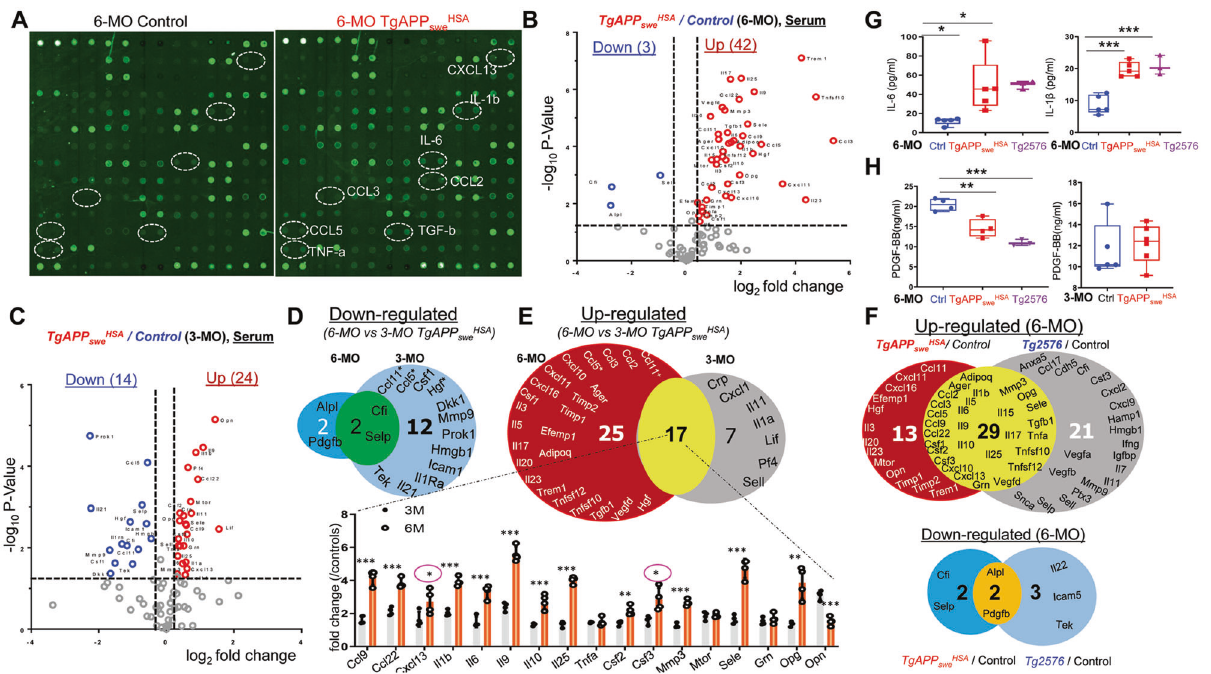
Fig. 5 Increased systemic in fl ammation in TgAPP sweHSA serum samples. A Representative images of serum L-Series label-multiplex antibody arrays of 6-MO control and TgAPP sweHSA mice. B Volcano plots analysis of ( A ). C Volcano plots analysis of the serum L-Series label-multiplex antibody arrays of 3-MO control and TgAPP sweHSA mice. D , E A comparison of the changes of downregulated ( D ) and upregulated ( E ) secreted factors in the antibody array between 3-MO and 6-MO. * p < 0.05, ** p < 0.01, *** p < 0.001, student ’ s t test and correction of multiple comparisons using Holm-Sidak method was applied, circle with asterisk means no signi fi cant change was detected after correction. F A comparison of the changes of the up- and down-regulated secreted proteins in 6-MO Tg2576 over control mice with those detected in 6-MO TgAPP sweHSA mice. G Elisa assays of serum IL1 β and IL6 level in 6-MO control, TgAPP sweHSA and Tg2576 mice. The data are presented as mean ± SD ( n = 5 mice). * p < 0.05, One-way ANOVA. H Elisa assays of serum PDGF-BB level in indicated mice. The data are presented as box and whiskers ( n = 3 – 6 mice). * p < 0.05, One-way ANOVA and student ’ s t test were (Fig. 6C, D) and co-immunostaining analysis using antibodies against P53 (Fig. 6E – G and Fig. S12). Notice that the increased P53 + immunosignals were selectively detected in the mutant hippocampal hilus region, but not cortex of TgAPP sweHSA mice (Fig. 6E – G and Fig. S12), in line with the view for the hilus region to be a more vulnerable region in response to the stress induced by the muscle APP swe . In addition, we veri fi ed the cellular senescence phenotype induced by expressing APP swe in C2C12 cells (Fig. 6H – K). C2C12 cells (a muscle cell line) expressing APP swe -GFP, but not APP